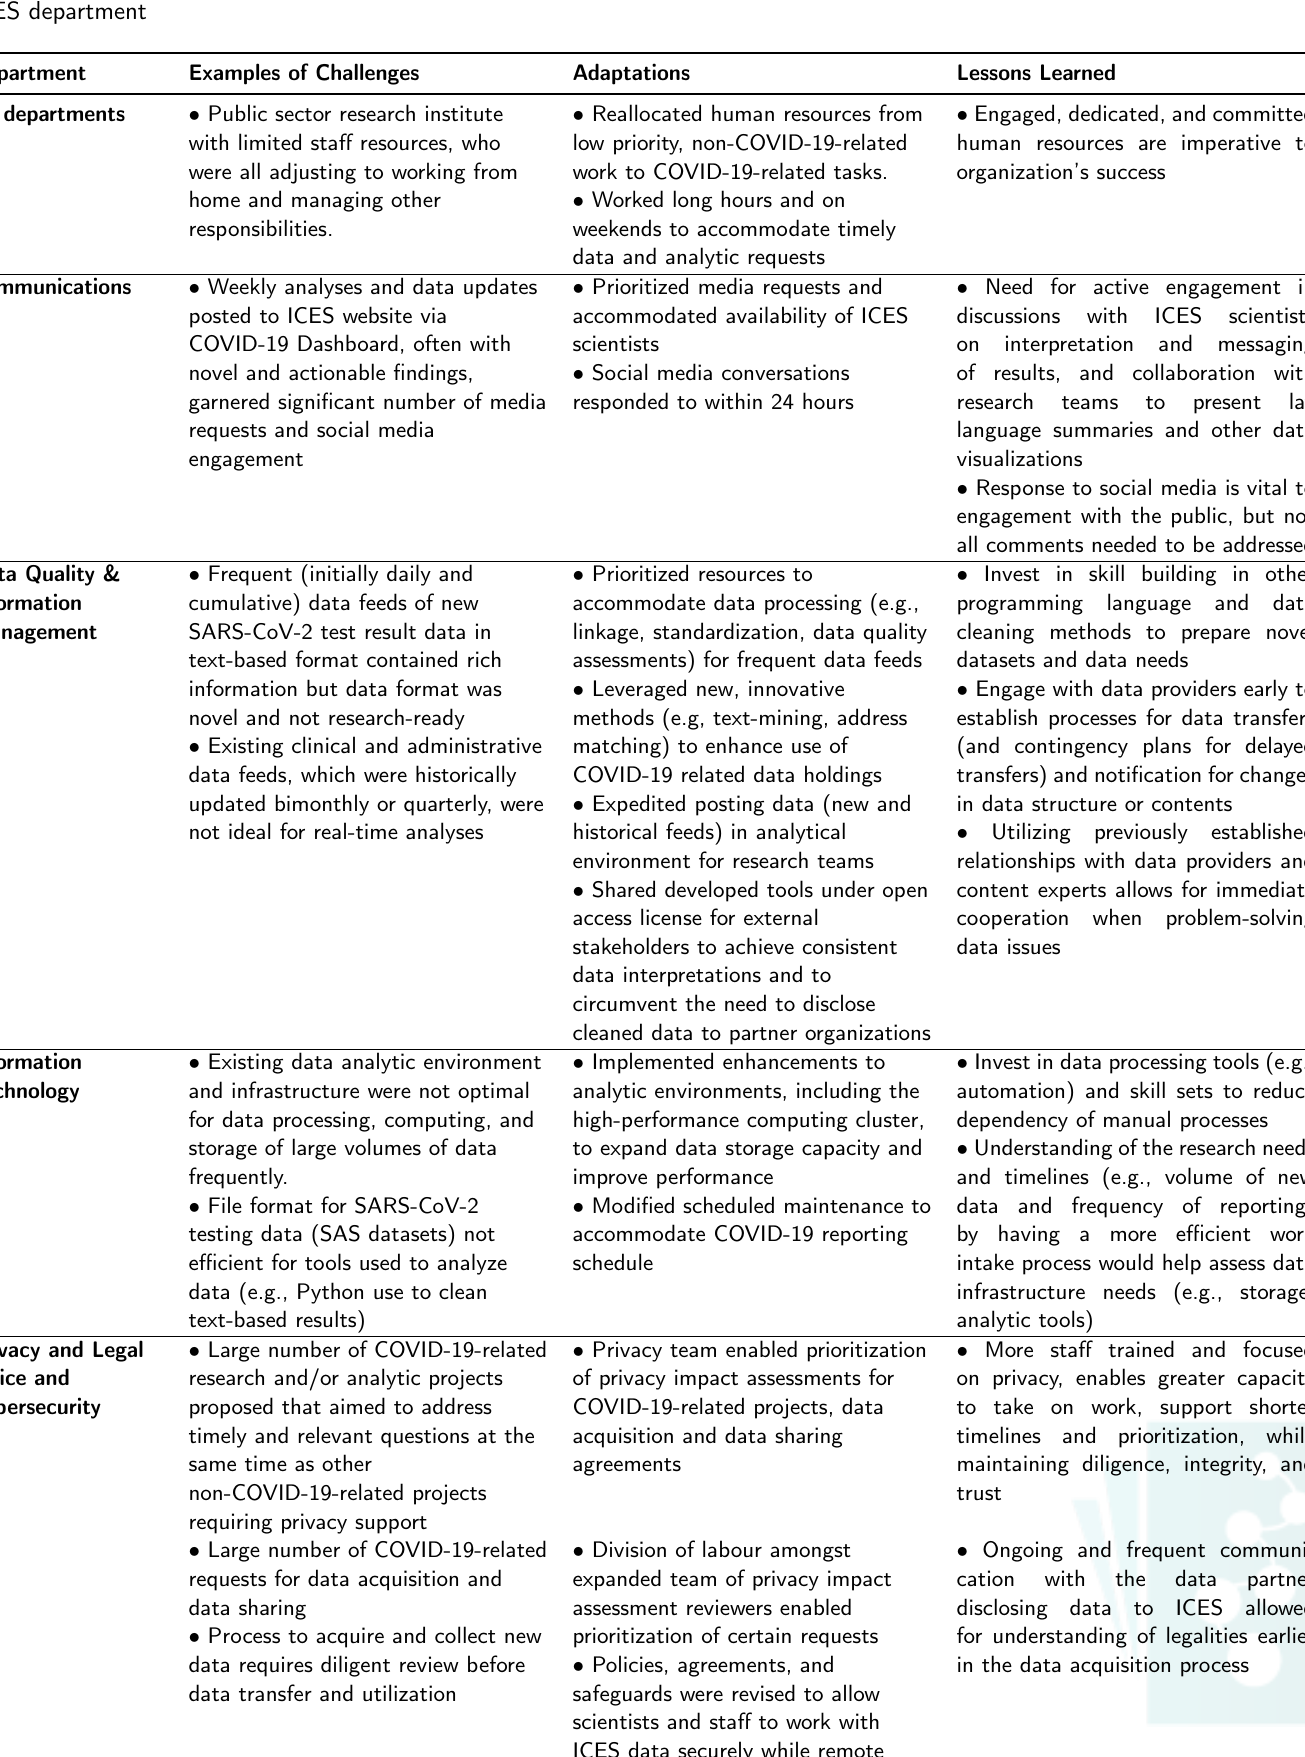
Table 1: Challenges, adaptations, and lessons learned in response to the data needs of Ontario’s COVID-19 pandemic response